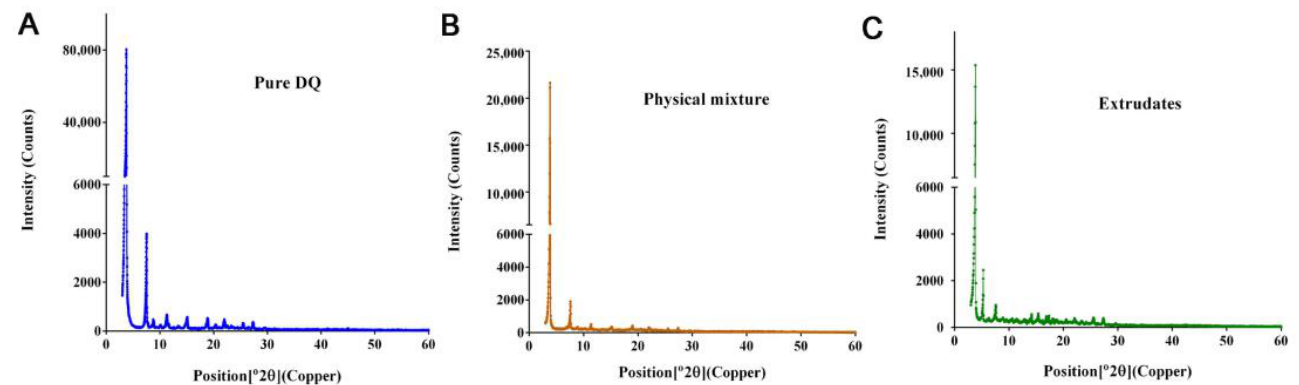
Figure 3. Physical features of SRFD. ( A ) X-ray diffraction graph of pure DQ powder; ( B ) X-ray diffraction graph of F2 made by HME; ( C ) X-ray diffraction graph of physical mixture of the same components of F2 prior to HME process. The peak heights of DQ from HME extrudates accounted for only a small percentage of the peaks of pure DQ.